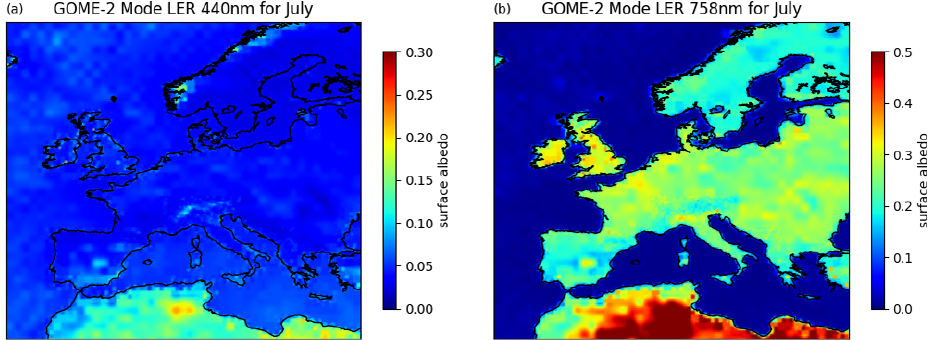
Figure 10. The GOME-2 July surface albedo map for 440 (a) and 758nm (b) . The data are from http://www.temis.nl/surface/albedo.html (last access: 7 March